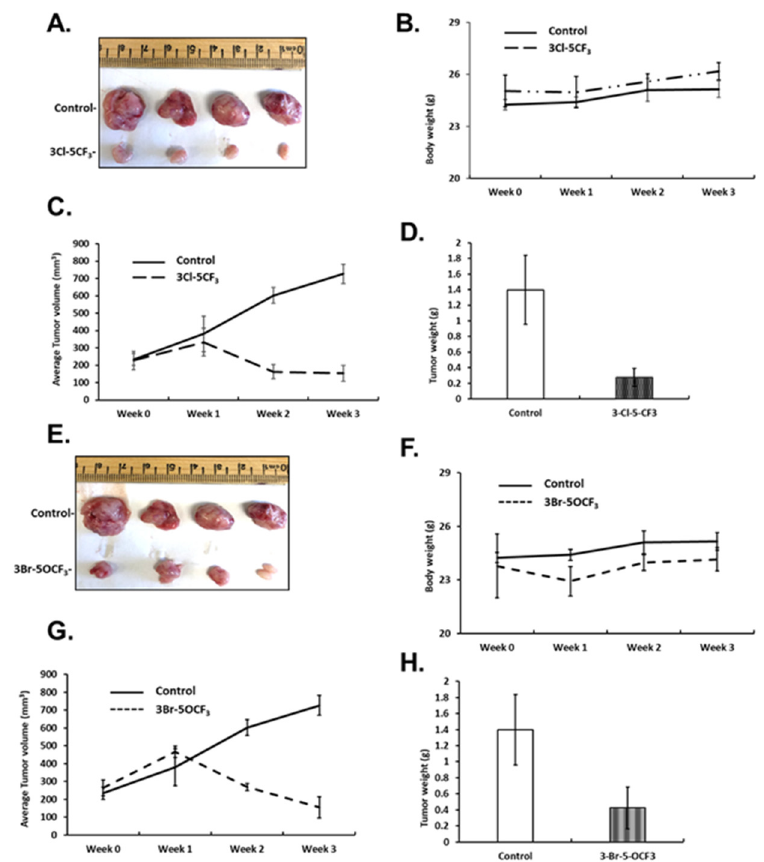
Figure 6. Inhibition of tumor growth by 3-Cl-5-CF 3 and 3-Br-5-OCF 3 phenyl-substituted CDIMs. Athymic nude mice were injected with MDA-MB-231 cells orthotopically and administered corn oil or 3-Cl-5-CF 3 (1 mg/kg) daily for 21 days. Effects on tumor volume ( A ), body weight ( B ), tumor growth ( C ), and weight ( D ) were determined, as outlined in the Materials and Methods section. The same protocol was used for 3-Br-5-OCF 3 (1 mg/kg/d) phenyl-substituted CDIM and effects on tumor volume ( E ), body weight ( F ), tumor growth ( G ), and weight ( H ) were determined.